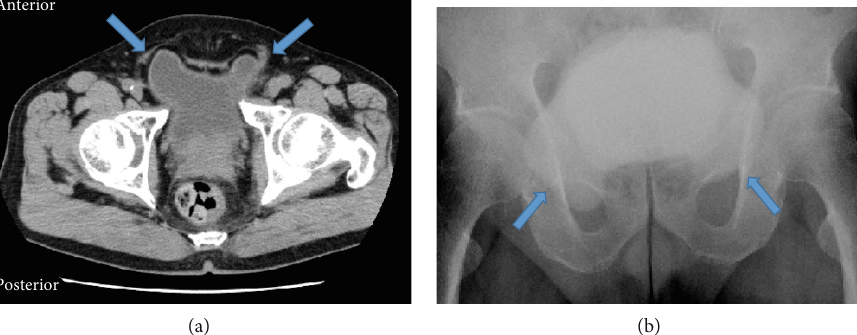
Figure 1: The images of case 1 showing the bladder in the right inguinal hernia. (a) Axial CT sections illustrate a small portion of the urinary bladder protruding into the bilateral inguinal canal with a “ Mickey mouse ” -like appearance. (b) Cystography shows the inverse “ Mickey mouse ”